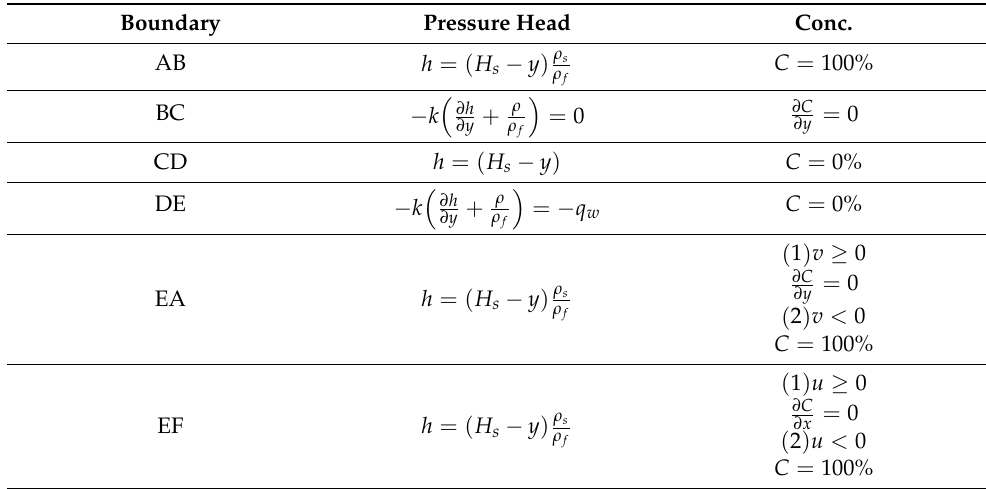
Table 4. Boundary